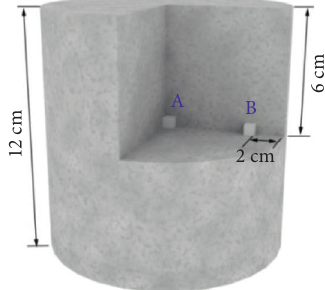
Figure 2: The sampling position for hydration and microstructure